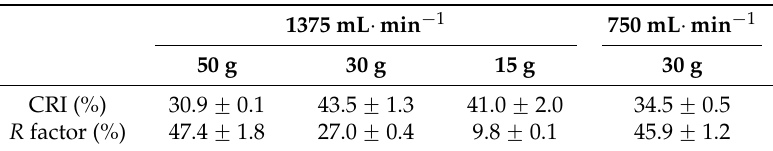
Table 10. Reactivity results of metallurgical